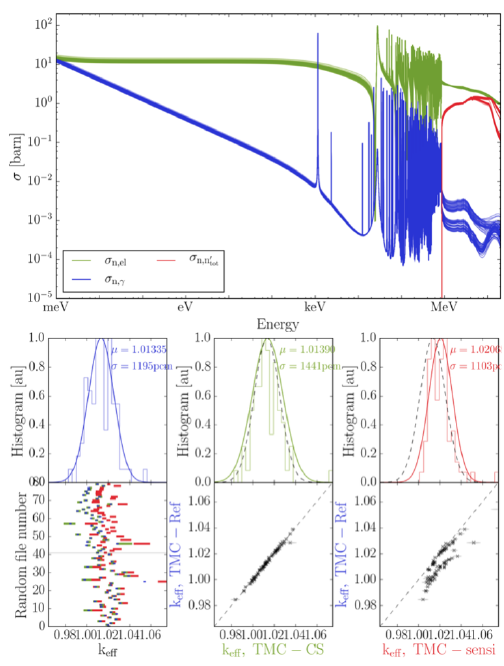
Figure 4. Extended TENDL library cross sections and corre- sponding uncertainty propagation (see legend of Fig.3